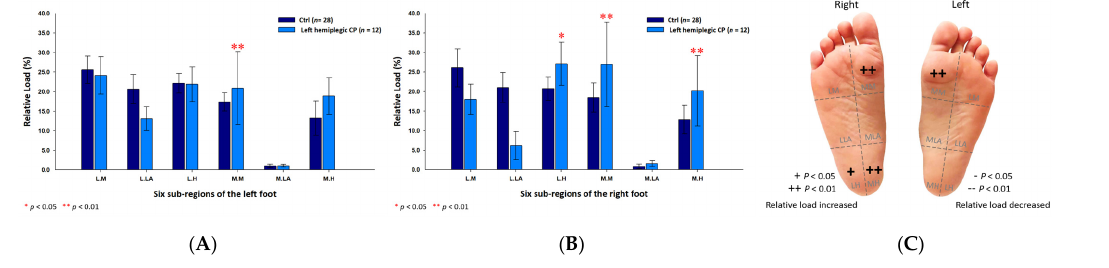
Figure 6. The percentage of six subregional relative loads of ( A ) left and ( B ) right feet in male students during static stance. The changes in pressure distribution are illustrated in ( C ) foot plantar diagram. Significant differences between the male control group and the male left hemiplegic CP group were determined as * p < 0.05 and ** p < 0.01.